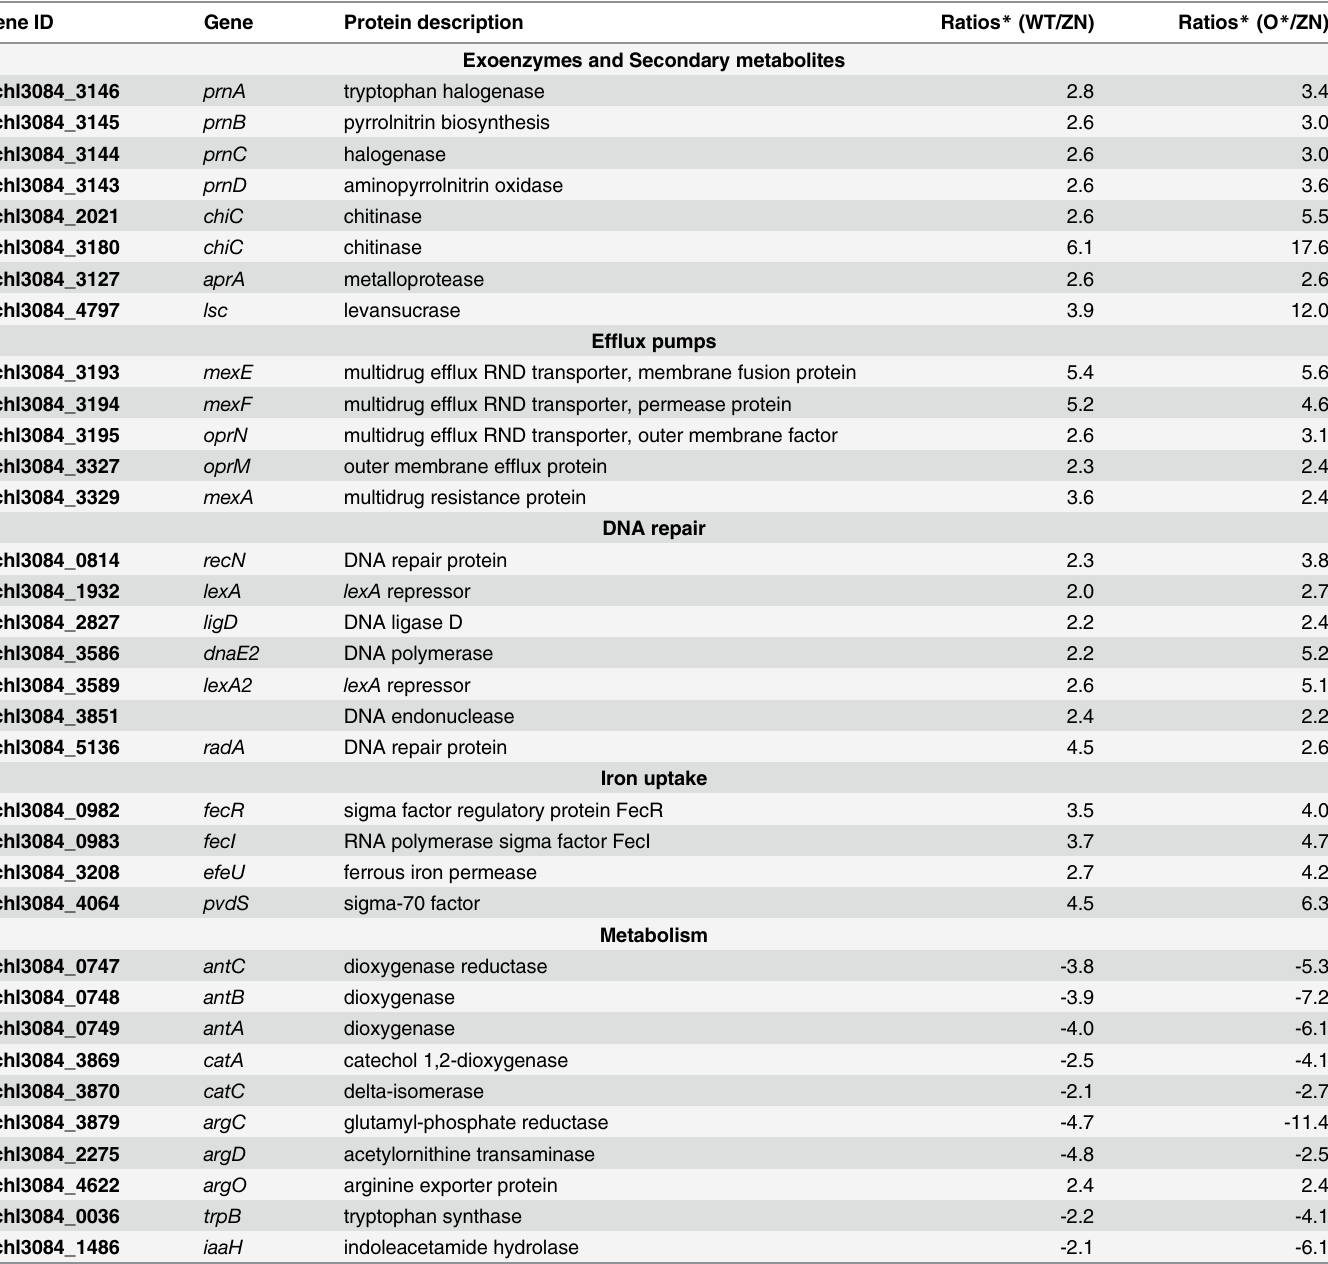
Table 4. Selected genes that were changed in expression (relative to 30-84ZN) only in wild type and 30-84O * biofilm matrices, e.g. are specifically affected by 2-OH-PCA production. Gene